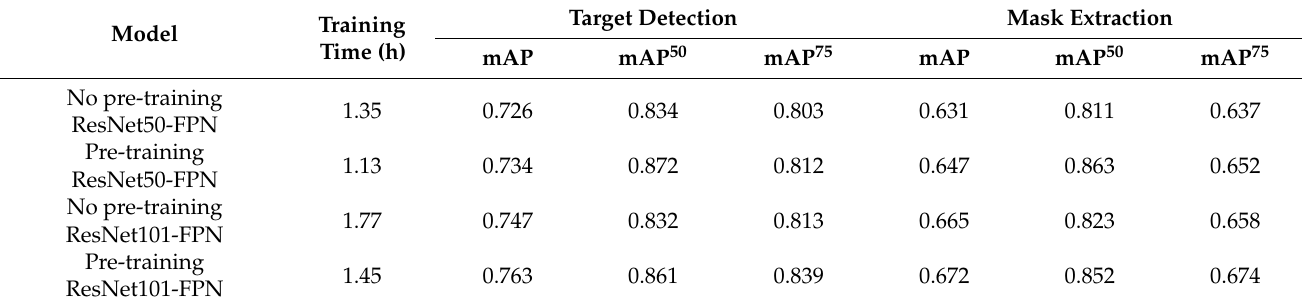
Table 2. Model performance obtained with different training methods.